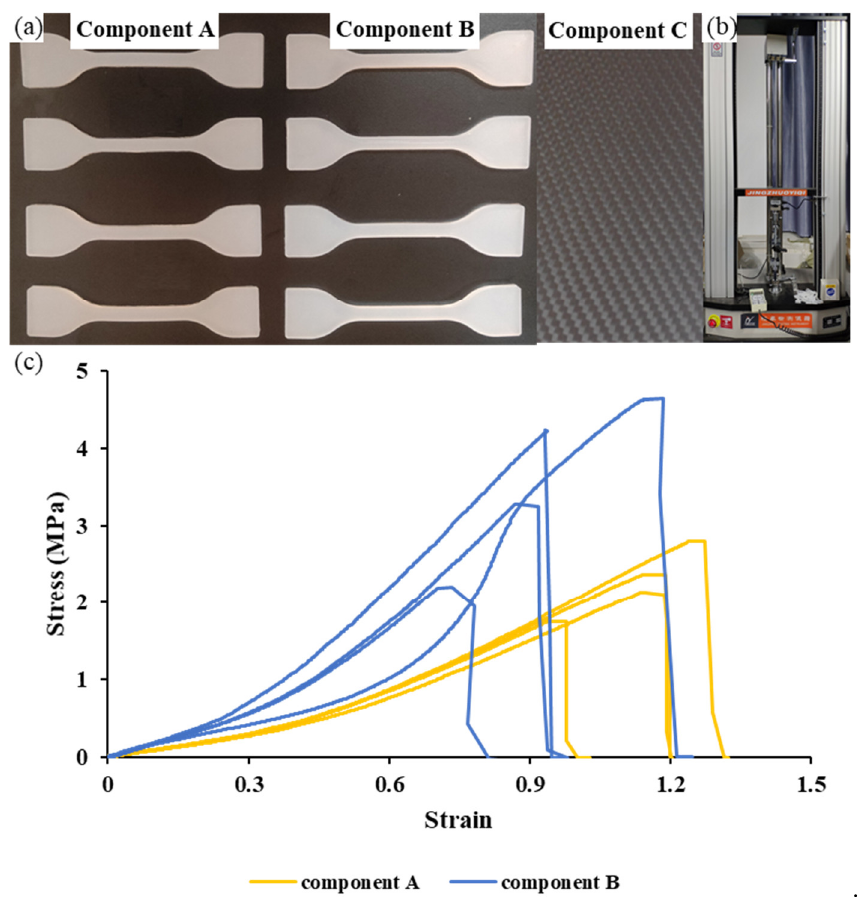
Figure 5. Tensile test for elastic moduli of materials: ( a ) three component materials; ( b ) tensile testing machine; and ( c ) results of tensile test.